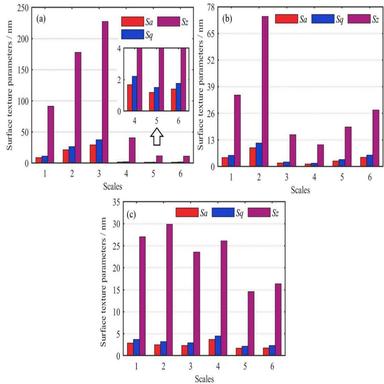
Surface texture parameters evaluated at different scales corresponding to under the machining conditions of: (a) I, (b) II, and (c) III.